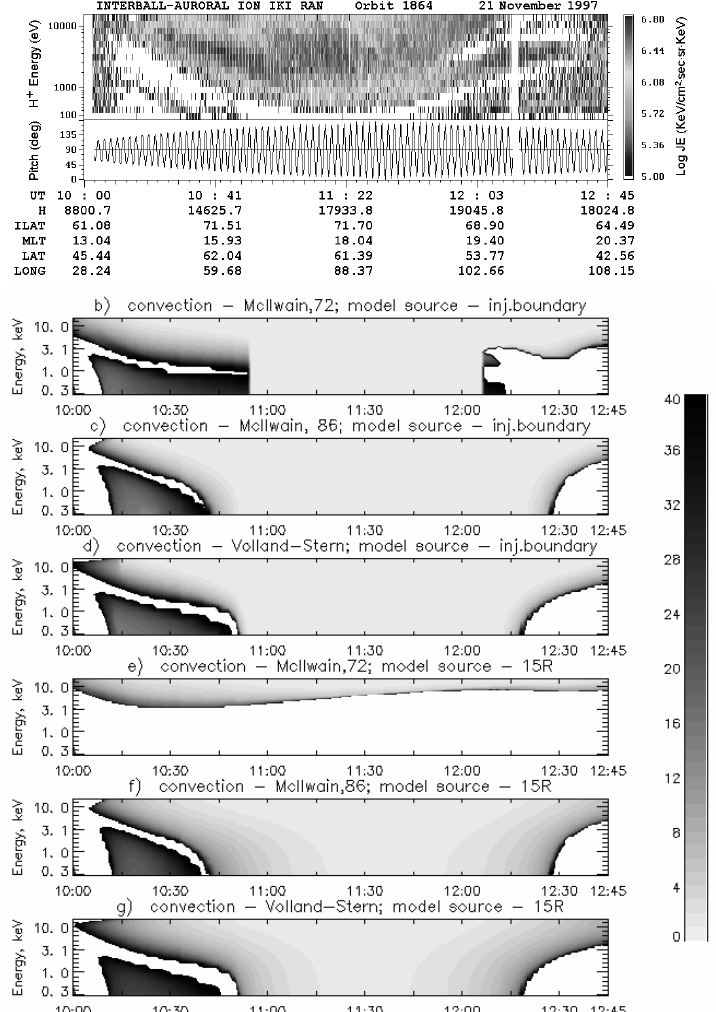
Fig. 7. (a) Proton energy-time spectro- grams and pitch angles for 21 Novem- ber 1997 (orbit 1864). (b)–(g) Modeled spectrograms calculated using the three convection models and the two mod- els of particle source. The calculated drift time is shown by a grey code from zero (light grey) to 40 hours (black).The white spaces correspond to the modeled gaps arising from two different mech- anisms – excessive ion drift times and “forbidden zones” for ion coming from the